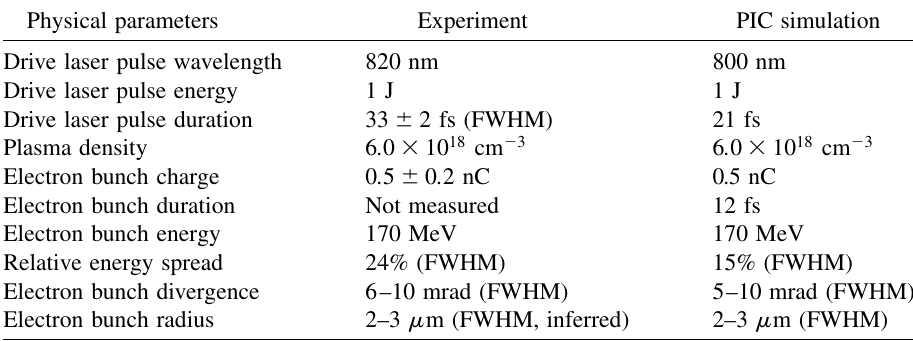
TABLE I. LWFA parameters from Ref.